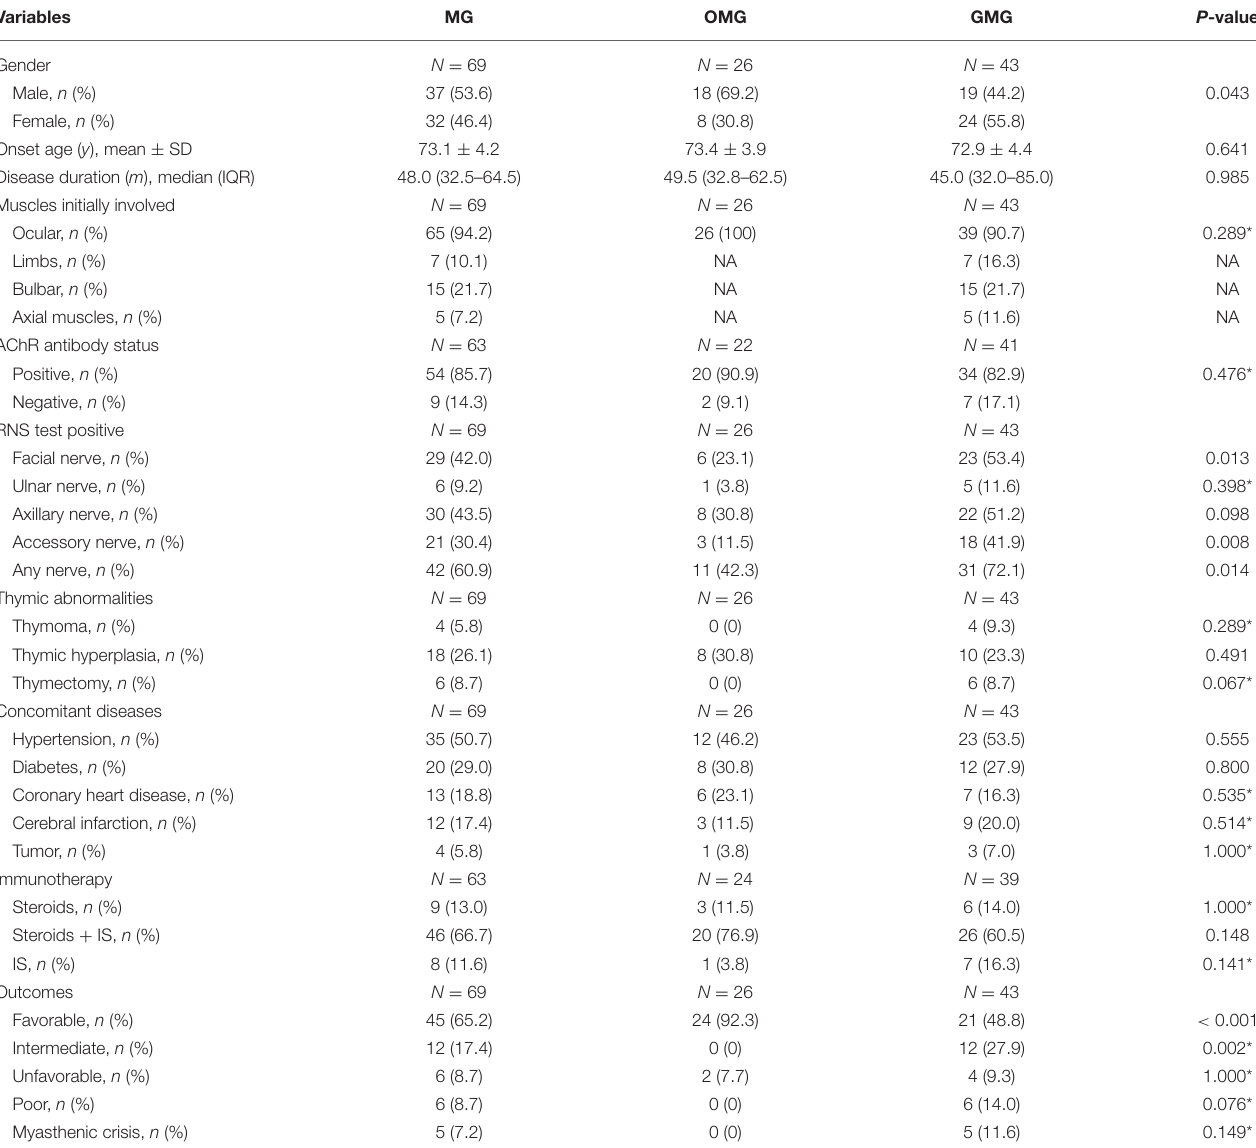
TABLE 1 | Demographic, clinical characteristics, and long-term outcomes of the patients with v-LOMG.